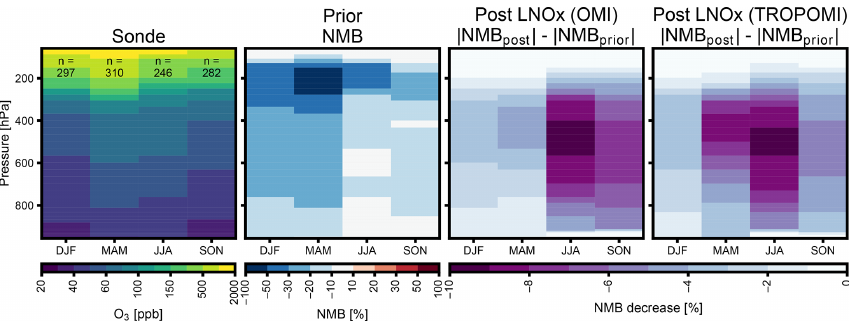
Figure 10. Ozonesonde observations from the WOUDC network and impact of lightning emissions inferences on modeled ozone. Left plot shows sonde observations averaged in each season and total number of launches per season. The NMB is shown for the prior emissions simulation. Plots on the right show the decrease in the NMB, relative to the prior simulation for simulations, with LNO x emissions updated with OMI and TROPOMI